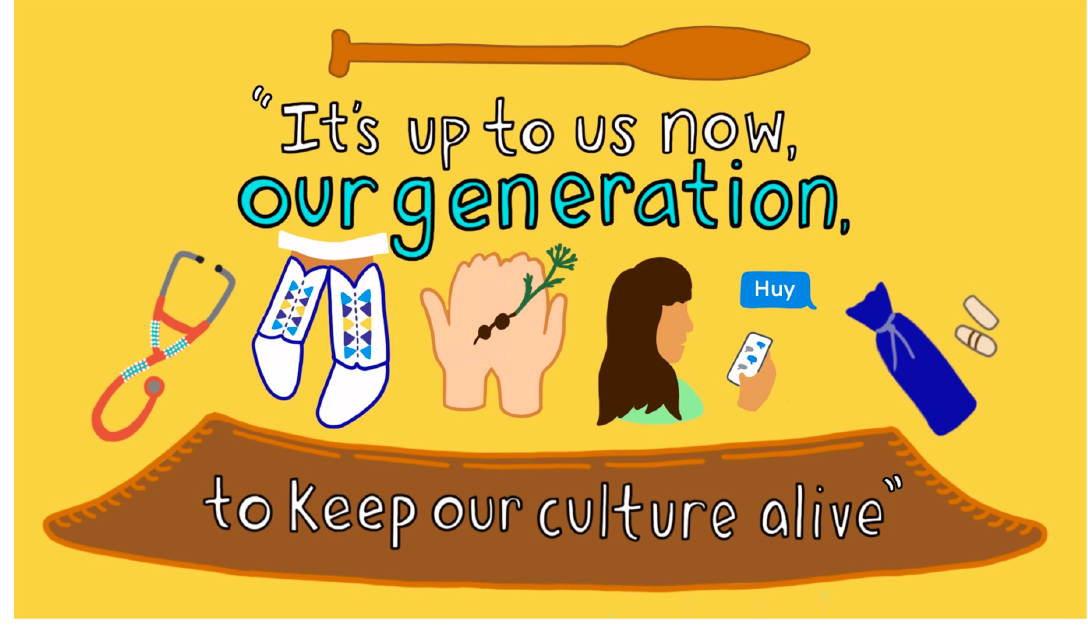
Figure 9. This panel includes a collage of images representing different aspects of keeping culture alive. See I.D. 9 in Appendix A.